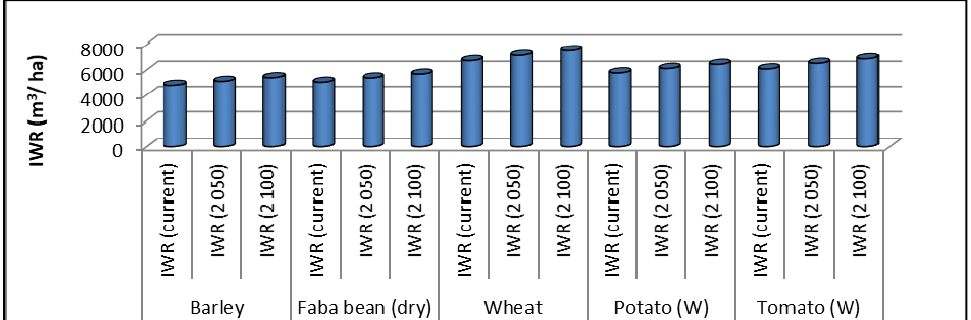
Figure 5. Average irrigation water requirements (IWR) for some main winter crops in Middle Egypt under current and climate change conditions over 30 years.